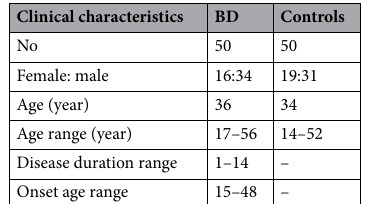
Table 2. Demographic and clinical characteristics of the BD patients and controls.